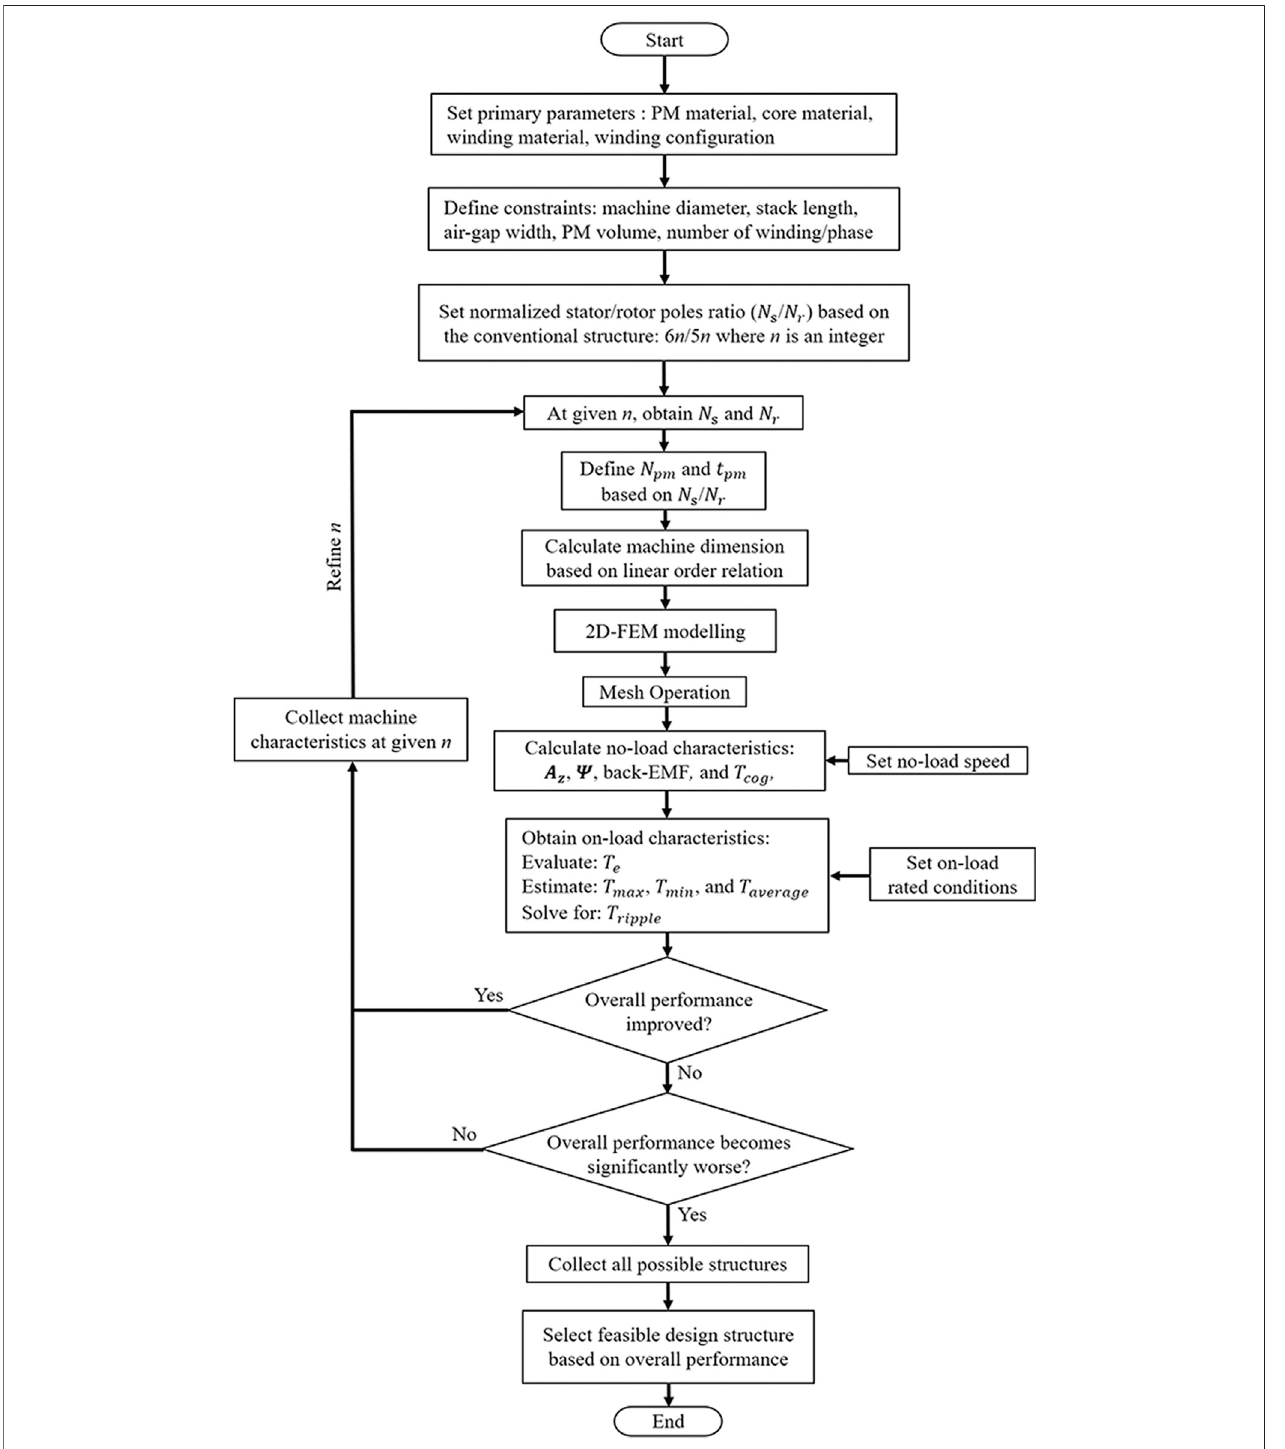
FIGURE 2 | A fl owchart indicating an optimization design process.